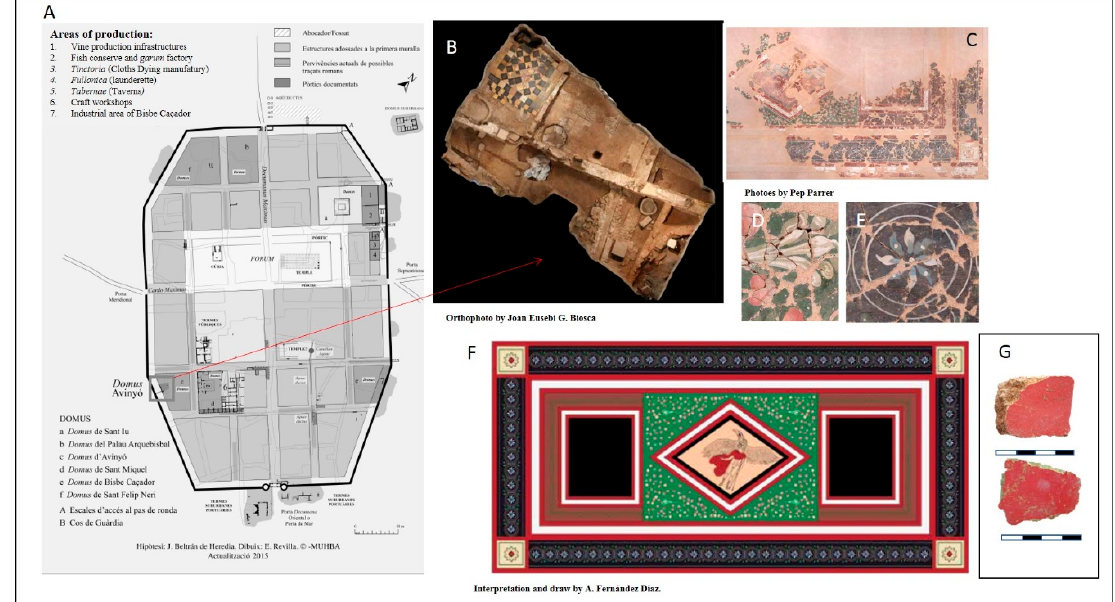
Figure 2. ( A ) The plan of Barcino [35]. ( B ) Orthophoto of the plan of the domus Avinyó [35]. ( C – E ): Wall paintings from the Triclinium and the Cubiculum [35]. ( F ): Interpretation of the central scene: Terpsichore and the muse [35]. ( G ): Two random fragments that the pigments BAR1a and BAR5e come from, presented as an example.